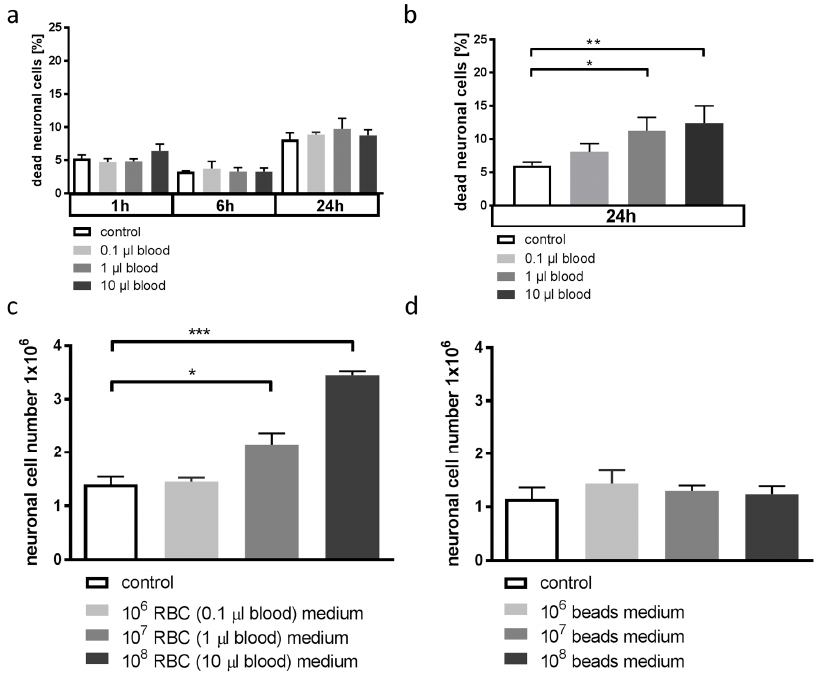
Figure 4. E ff ect of conditioned microglia medium on neuronal cell death and growth. ( a ) Quantification of flow cytometry plots after annexin V / PI staining of HT22 cells incubated with BV-2 microglia medium conditioned with 10 µ L blood and then exposed to blood at the indicated amounts. Microglia medium was first conditioned as described in the methods. Conditioned medium was added to HT22 cells and cells were then exposed to blood. The % neuronal dead cells from total of n = 6 experiments. p = n.s. for all comparisons. ( b ) Quantification of flow cytometry plots after annexin V / PI staining of HT22 cells incubated with BV-2 microglia medium incubated with 10 8 sterile latex beads and then exposed to blood at the indicated amounts. Microglia medium was first conditioned with beads as described in the methods. Conditioned medium was added to HT22 cells and cells were then exposed to blood. The % neuronal dead cells from total of n = 3 experiments. * p = 0.0133 control vs. 1 µ L blood, ** p = 0.0031 control vs. 10 µ L blood. ( c ) Microscopic cell count of neuronal HT22 cells incubated with blood-conditioned microglia medium. Microglia were exposed to the indicated amount of blood for 24 h. Conditioned medium was then added to HT22 cells for 24 h before analysis. * p = 0.0325 untreated medium vs. 10 7 RBC-conditioned medium, *** p = 0.0007 untreated medium vs. 10 8 RBC-conditioned medium, n = 6 experiments. ( d ) Microscopic cell count of neuronal HT22 cells incubated with bead-conditioned microglia medium. Microglia were exposed to the indicated amount of sterile latex beads for 24 h. Conditioned medium was then added to HT22 cells for 24 h before analysis. p = n.s. for all